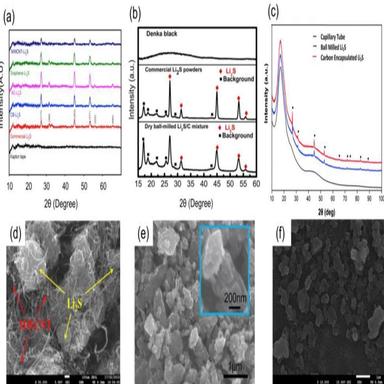
The XRD patterns (a–c) and SEM images (d–f) of different Li2S-C composite materials made by ball milling commercial Li2S-MCs. (a and d) Li2S-MWCNTs; (b and e) Li2S-CB; and (c and f) Li2S@HC . Reproduced from Refs. with permission from Elsevier, the American Chemical Society and Royal Society of Chemistry.